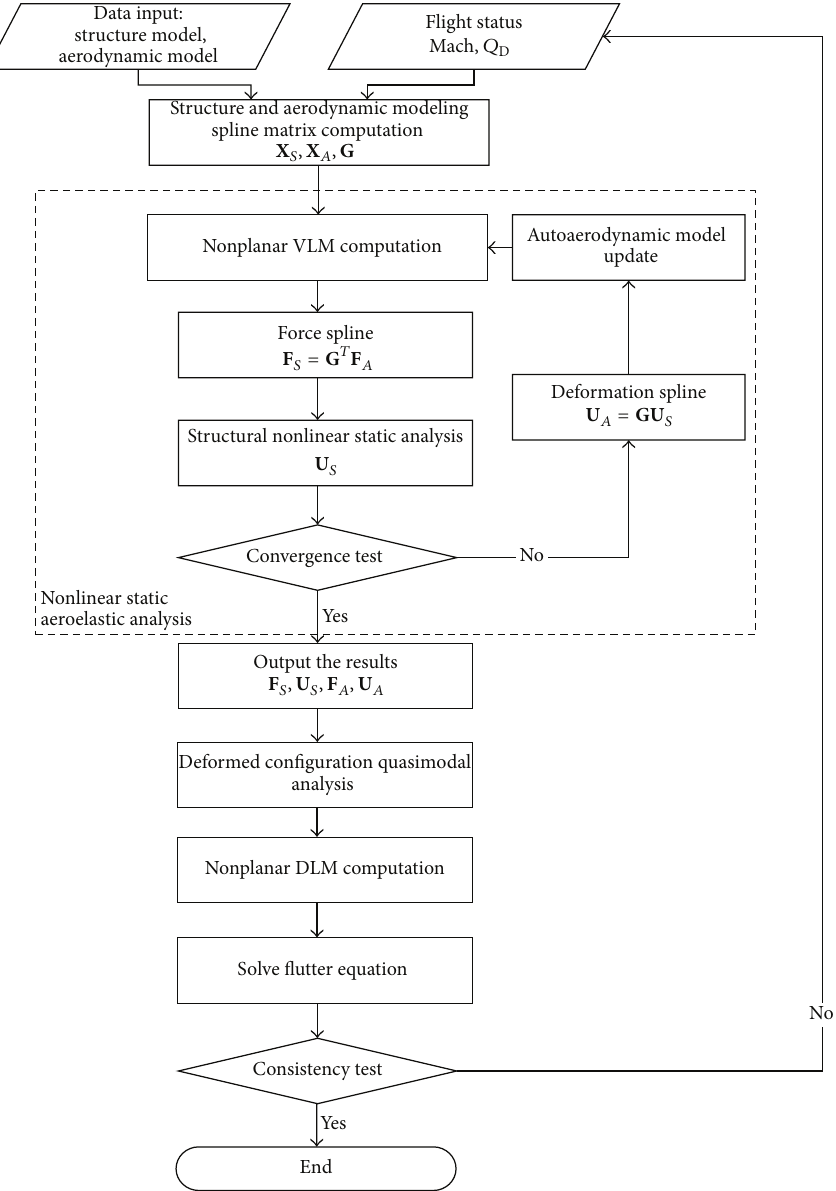
Figure 6: Geometric nonlinear aeroelastic analysis flowchart.